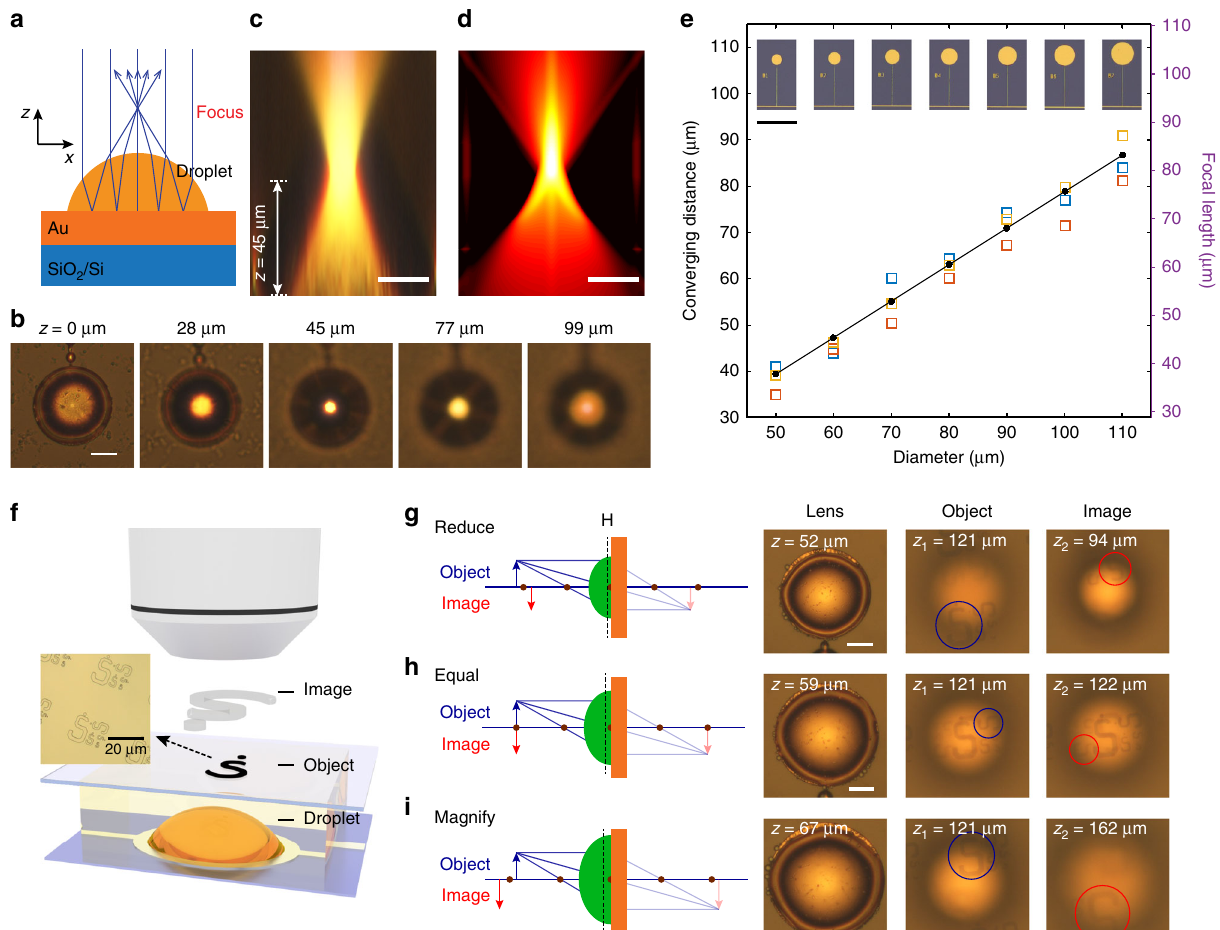
Fig. 4 Electrotunable liquid microlenses. a Schematic and b optical microscopy images of a microlens based on a 60- µ m sulfur droplet with a converging distance of 45 µ m. c Measured intensity pro fi le with cross sections in the xy plane. d Calculated intensity pro fi le from ray tracing, scale bar in ( b – d ) is 20 µ m. e The focal length of the microlenses can be tuned as a function of the diameter of the sulfur droplets, scale bar in ( e ) is 200 µ m. The squares are experimental data and the black dots are simulated data. f Imaging of the letter “ S ” patterned on a cover glass slide with sulfur droplet-based microlenses, with g reduced, h equal, and i magni fi ed images. The dashed lines in the schematics denoted by H indicate the location of the principal plane of the microlenses. scale bar in ( g – i ) is 20 µ